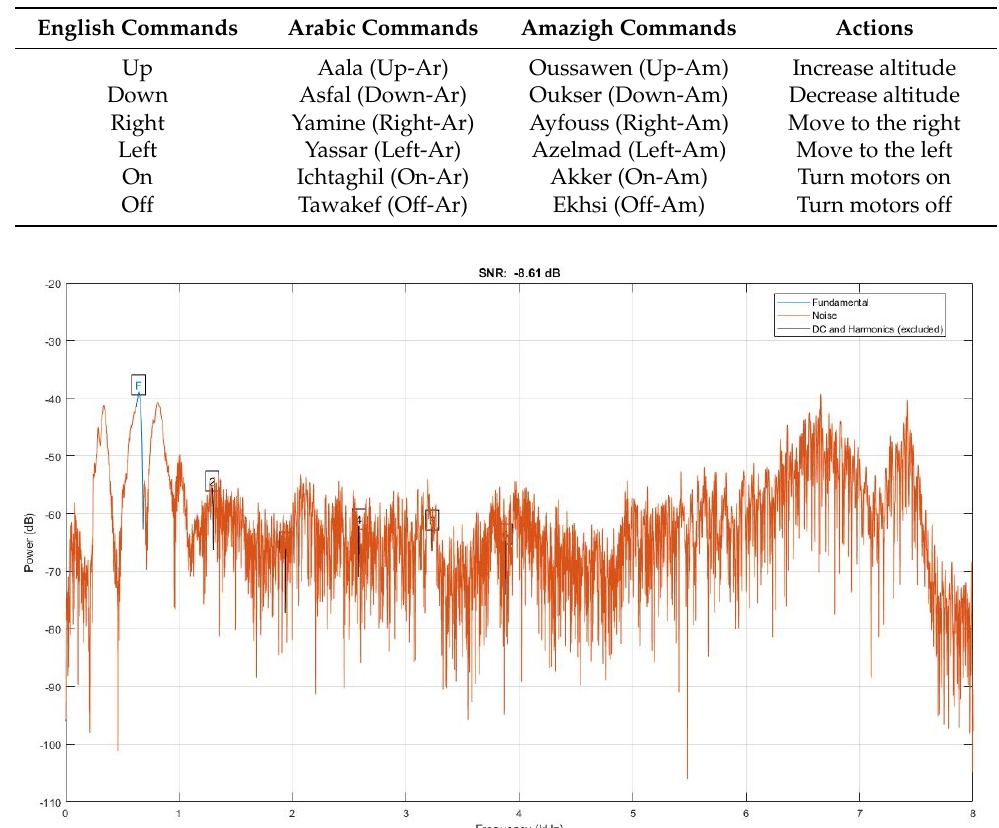
Table 2. Commands in English, Arabic and Amazigh.